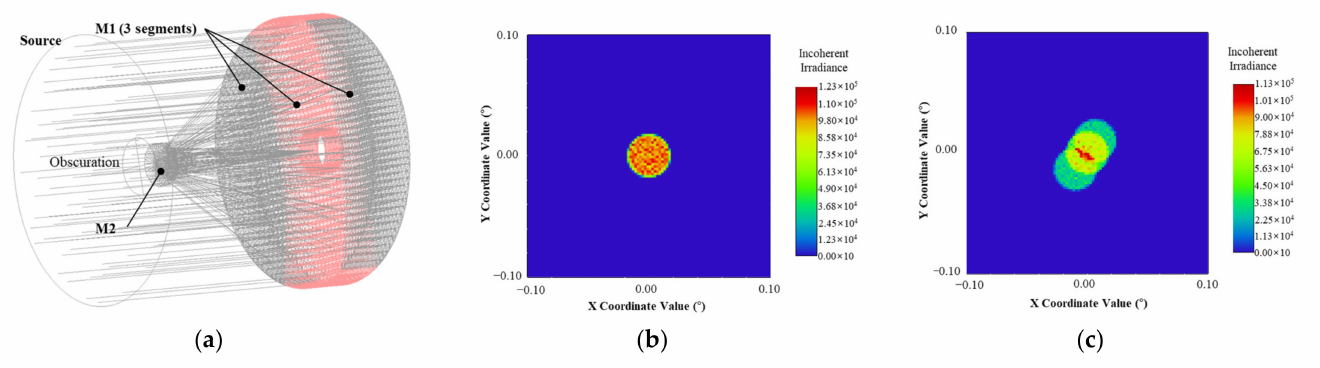
Figure 11. Payload optical system design and spot distortion analysis for the deployable space telescope: ( a ) raytracing for the deployable space telescope with three segmented mirrors; ( b ) nom- inal spot configuration on tracking sensor (CAM); ( c ) distorted spot configuration on tracking sensor